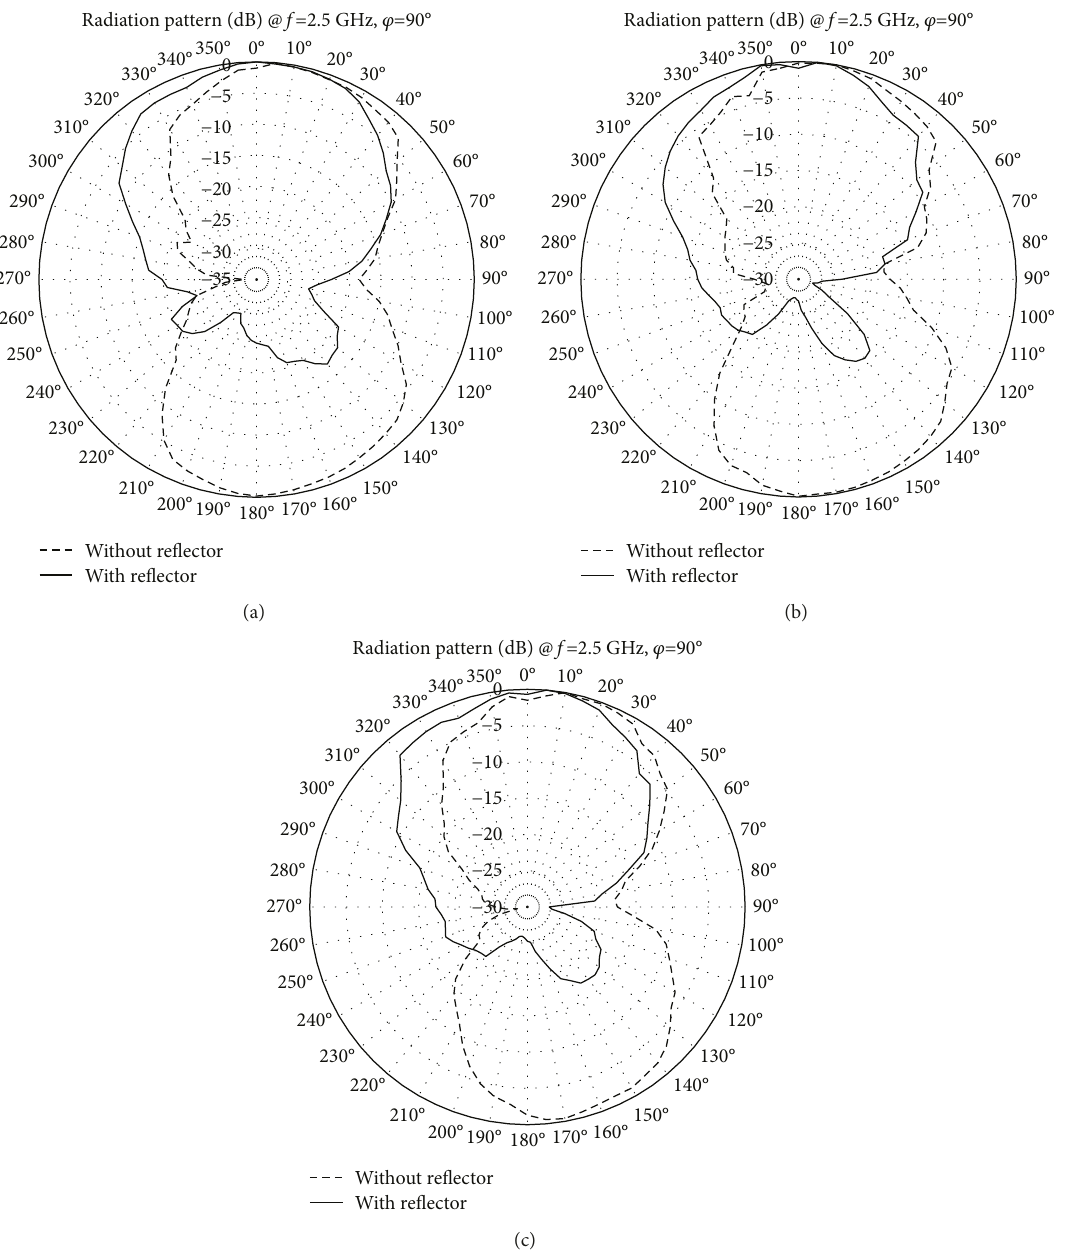
Figure 7: Experimental results achieved for the radiation patterns: (a) prototype fabricated exploiting Fabric #1; (b) prototype fabricated exploiting Fabric #2; (c) prototype fabricated exploiting Fabric #3. Table 1: Experimental data achieved for the three prototypes with the re fl